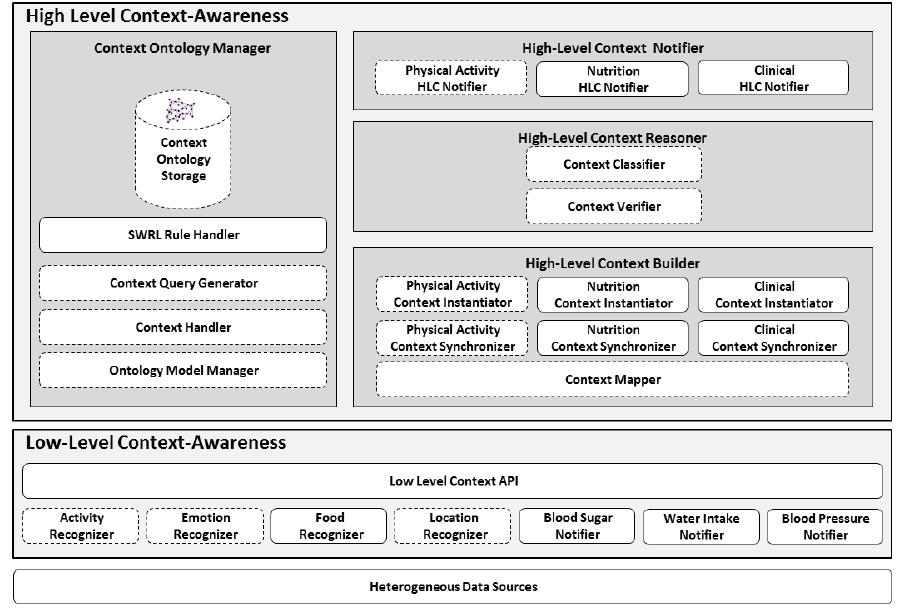
Figure 4. Mining Minds High-Level Context Awareness extended